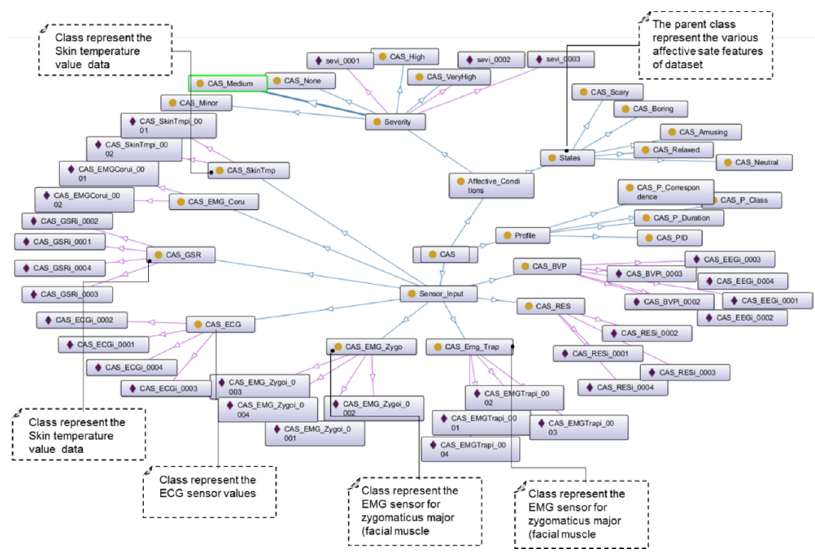
Figure 22. Semantic dataset B ontology.